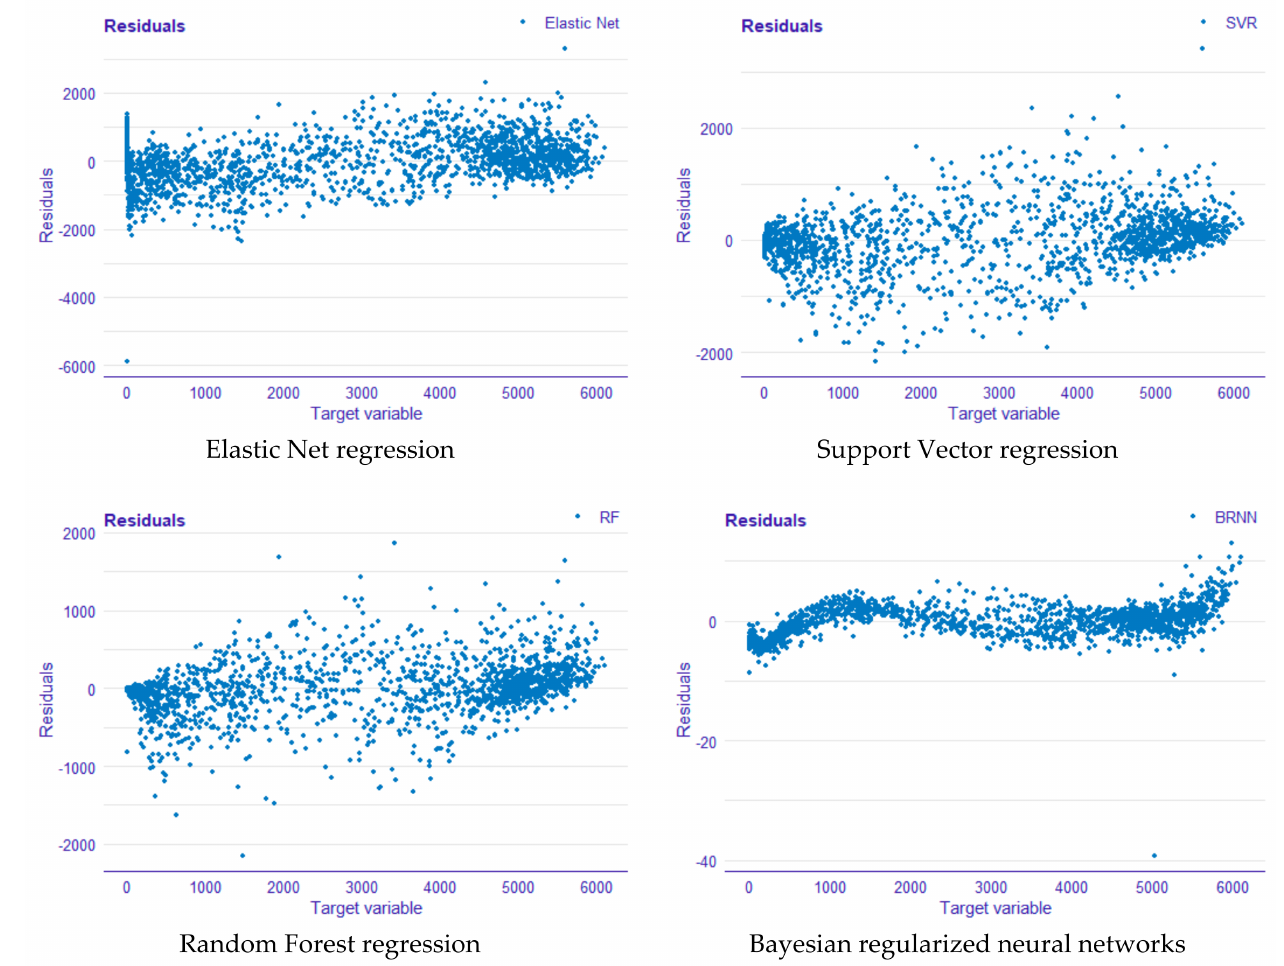
Figure 5. Residuals versus observed values plots. The second plot represents the residual boxplot. It depicts the distribution of absolute residual values as illustrated in Figure 6.